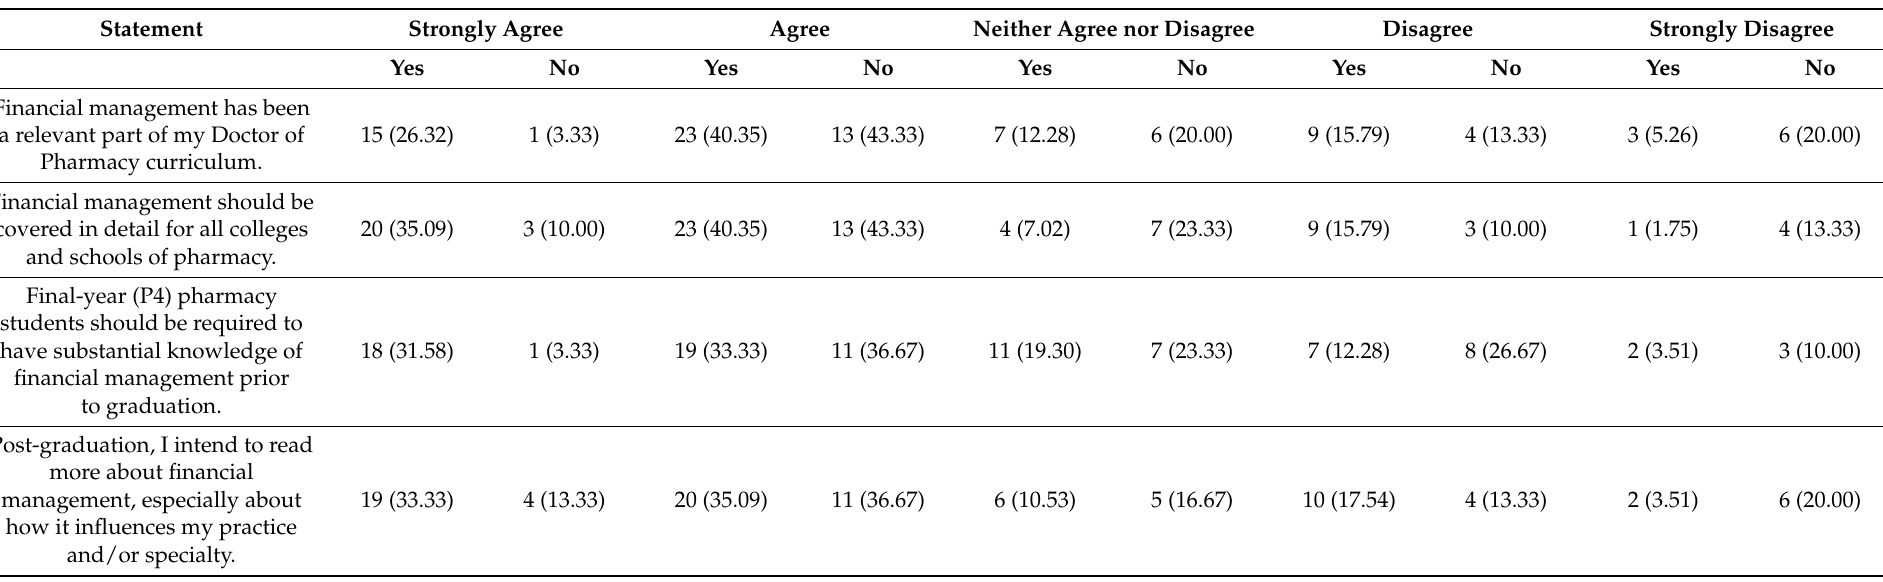
Table A4. Attitudes toward pharmacy financial management education by business related courses prior to pharmacy school (N =